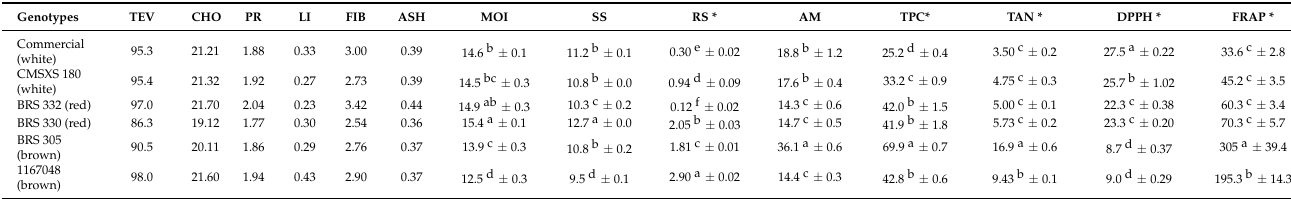
Table 2. Chemical composition of cooked sorghum GFPa.